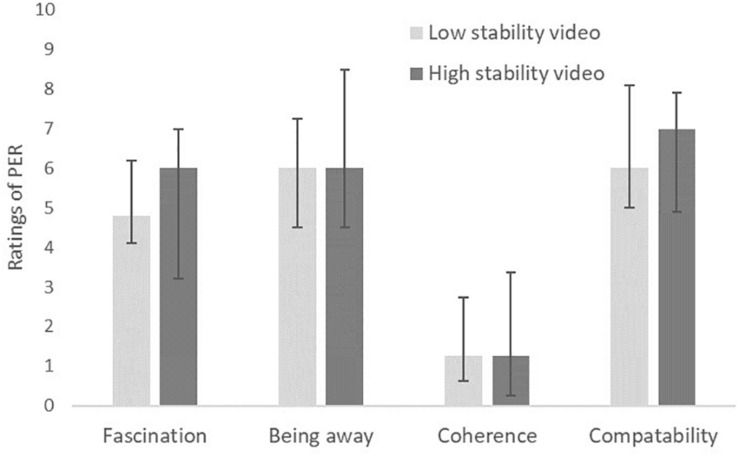
Comparison of ratings of the four components of the perceived restorativeness scale (PER) associated with a low- or high-stability 360° video (n = 50; medians and IQRs).